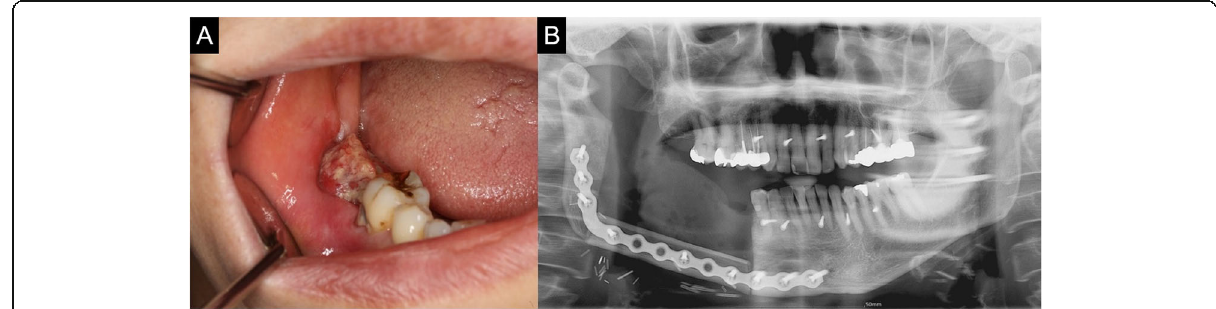
Fig. 5 a Lesion on intraoral site. b Reconstruction with fibular free flap after mandible resection